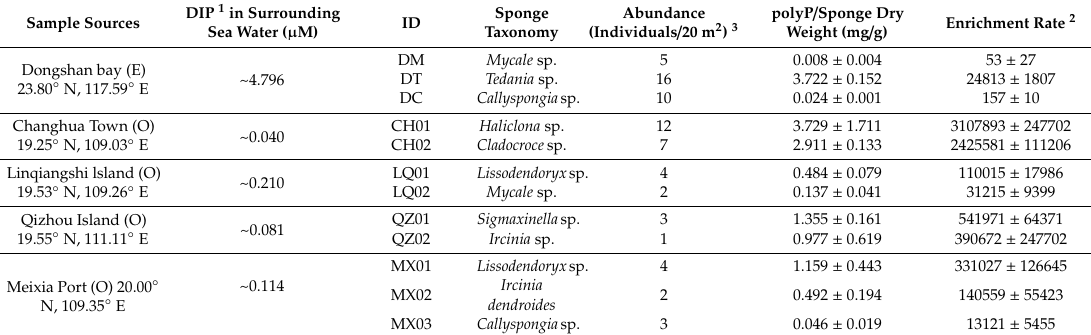
Table 1. Phosphorus sequestration in the form of polyphosphate by sponges in oligotrophic and eutrophic marine environments ( n = 3 for each